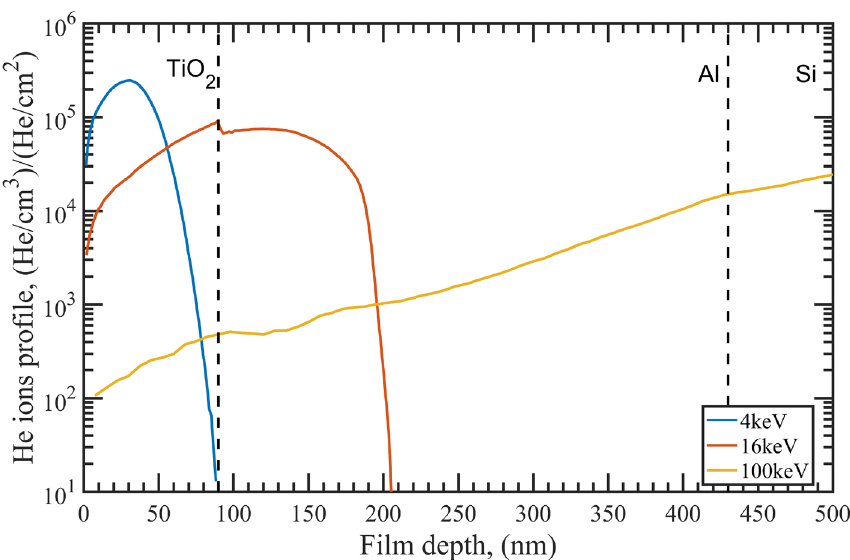
Figure 1. Stopping range of He + ions determined by simulations of collision dynamics with the TRIM/SRIM software for the energies used in the